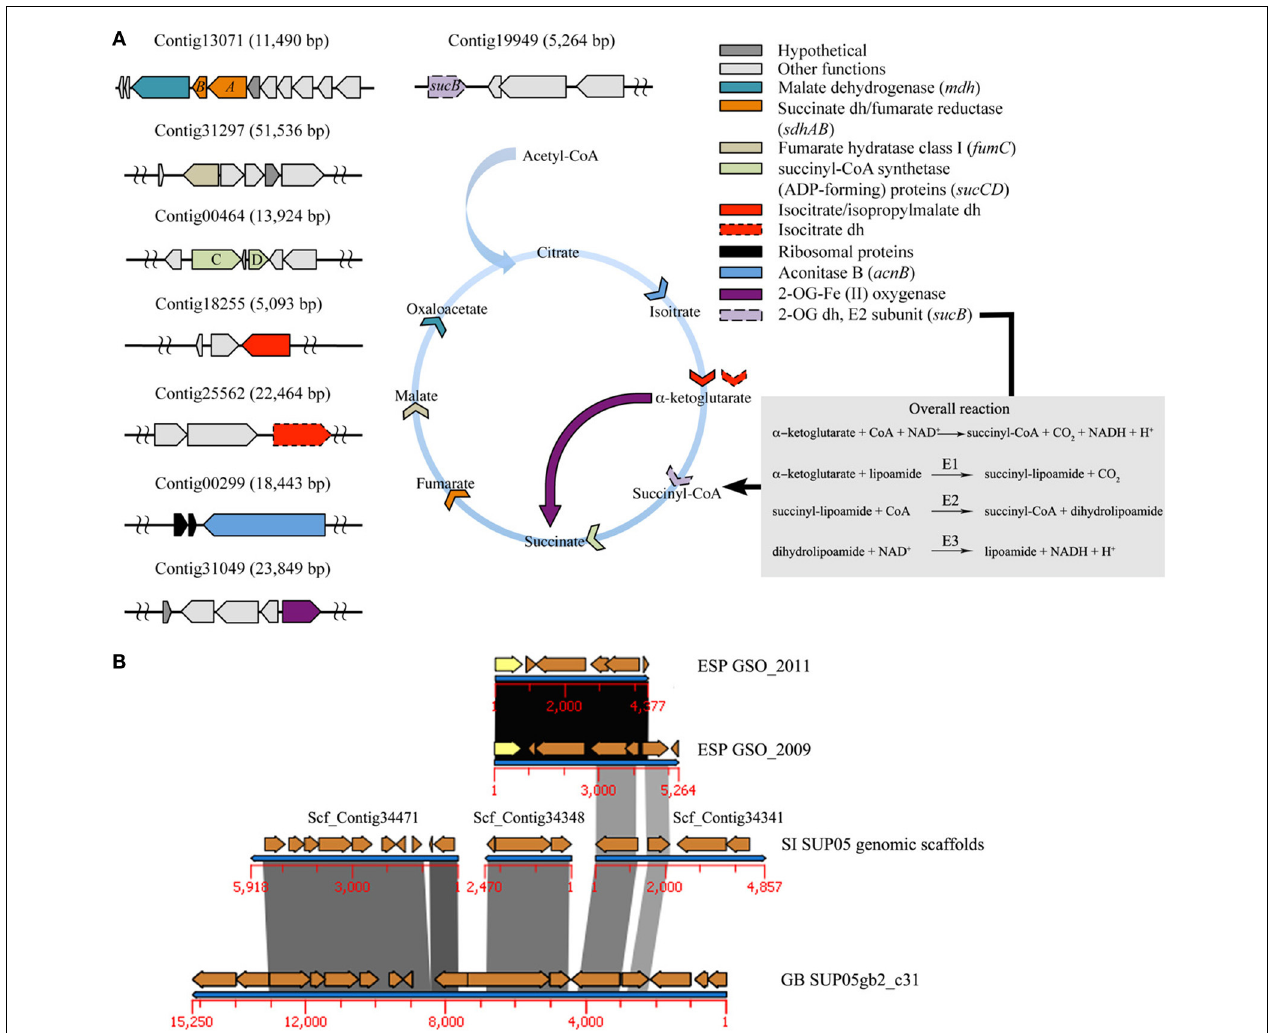
FIGURE 3 | Complete TCA cycle. (A) Sequences for each step of the TCA were retrieved from the metagenomic data associated with the ESP-GSO lineage bacterium. The color arrowheads show the specific function in the cycle for each enzyme. The overall reaction and semi-reactions for the α -ketoglutarate dehydrogenase complex are shown in the inset; the E2